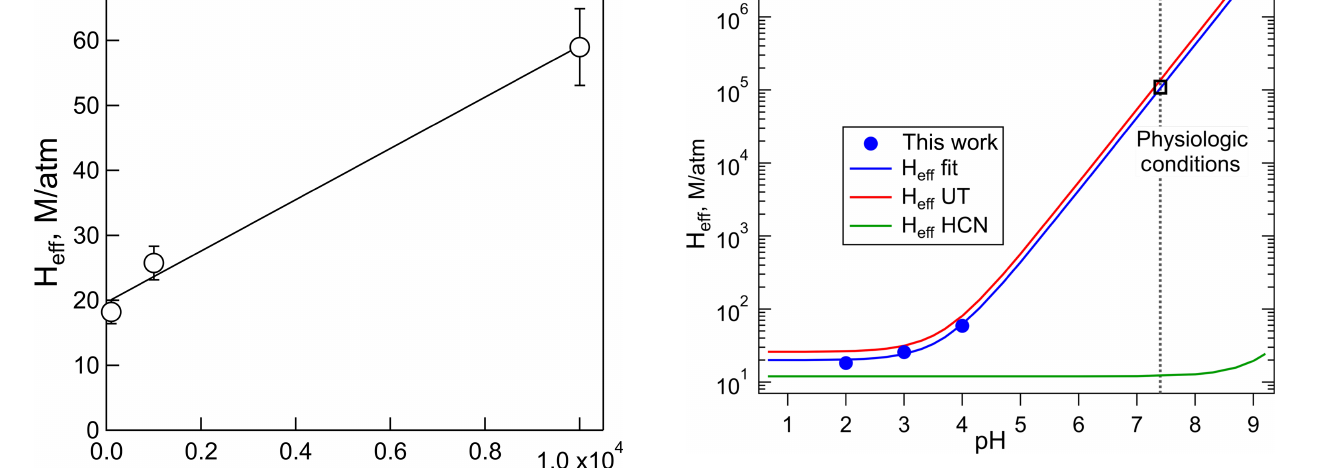
Figure 4. Comparison of the effective Henry’s coefficients of HNCO measured in this work (blue) with those reported by Bor- duas et al. (2016) plotted versus pH, according to Eq. (4). The error bars on our H eff values are smaller than the width of the symbols. The green line was calculated for HCN from the intrinsic H coeffi- cient reported by Sander (2015), and its pK a , 9.3.